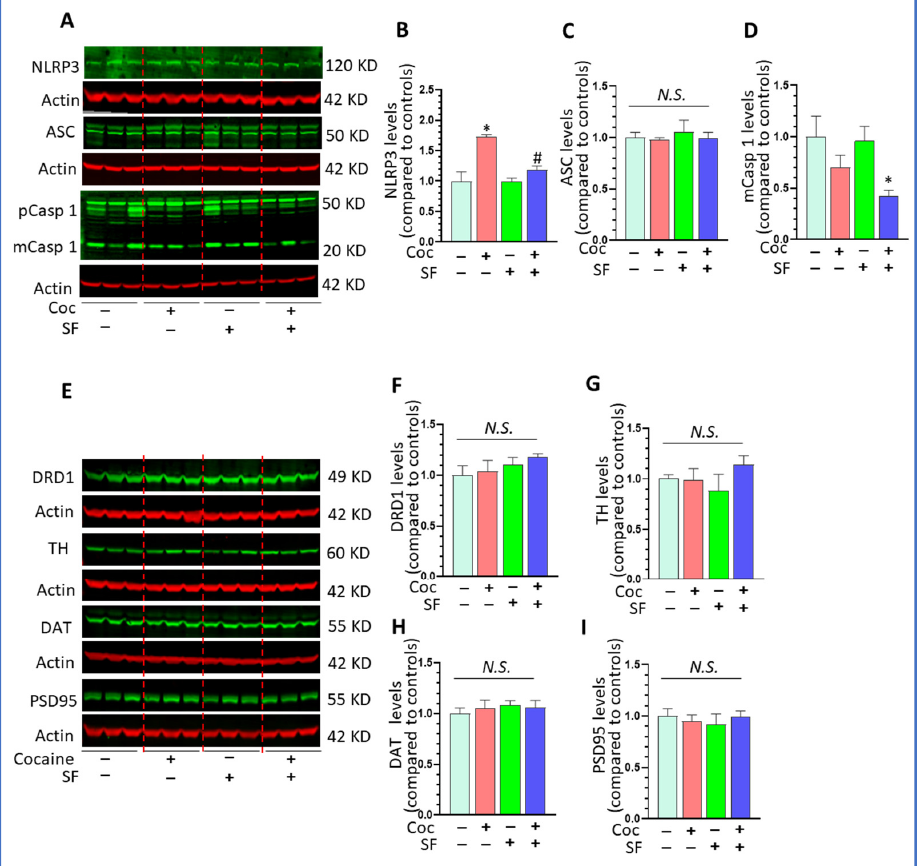
Figure 5. Effects of cocaine and SF on NLRP3 inflammasome and dopamine signaling in vivo. ( A )